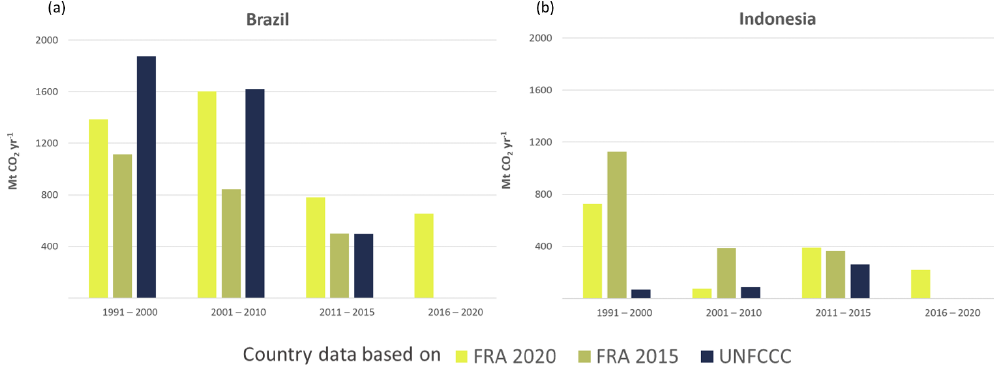
Figure 7. Comparison of estimates of emissions from net forest conversion (NFC) for Brazil (a) and Indonesia (b) in MtCO 2 yr − 1 , based on FRA 2020 (acid green) and FRA 2015 (olive green), to country data reported to the UNFCCC for deforestation (cadet